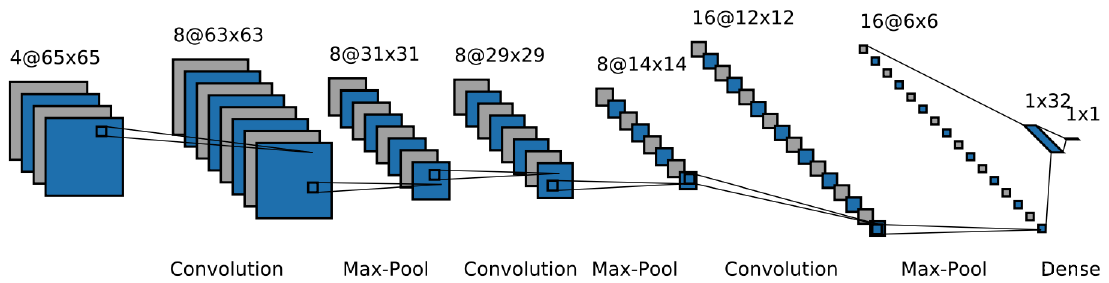
Figure 11. Nine-layer CNN architecture used to classify pixels as